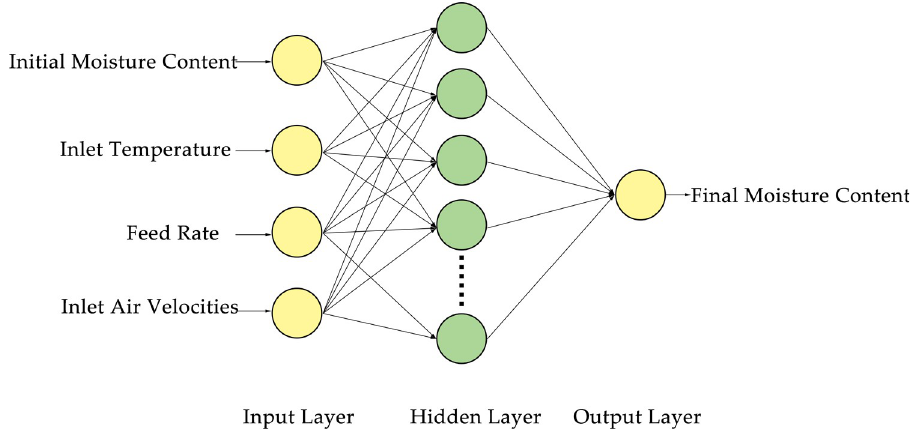
Fig 7. BP structure of wood fiber moisture content